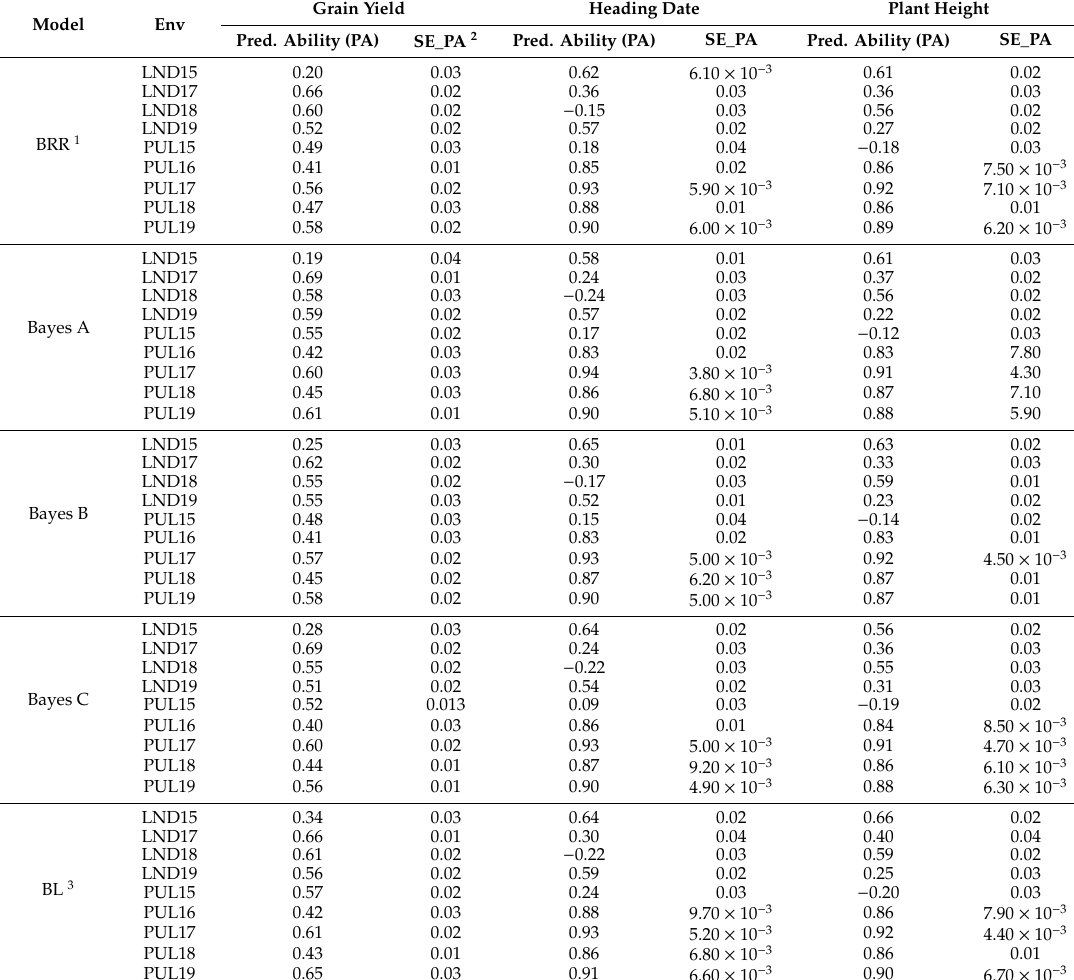
Table 5. Predictive ability from cross-validations for grain yield, heading date, and plant height for phenotypic values adjusted using genomic (marker) information from various Bayesian models. Grain Yield Model Env